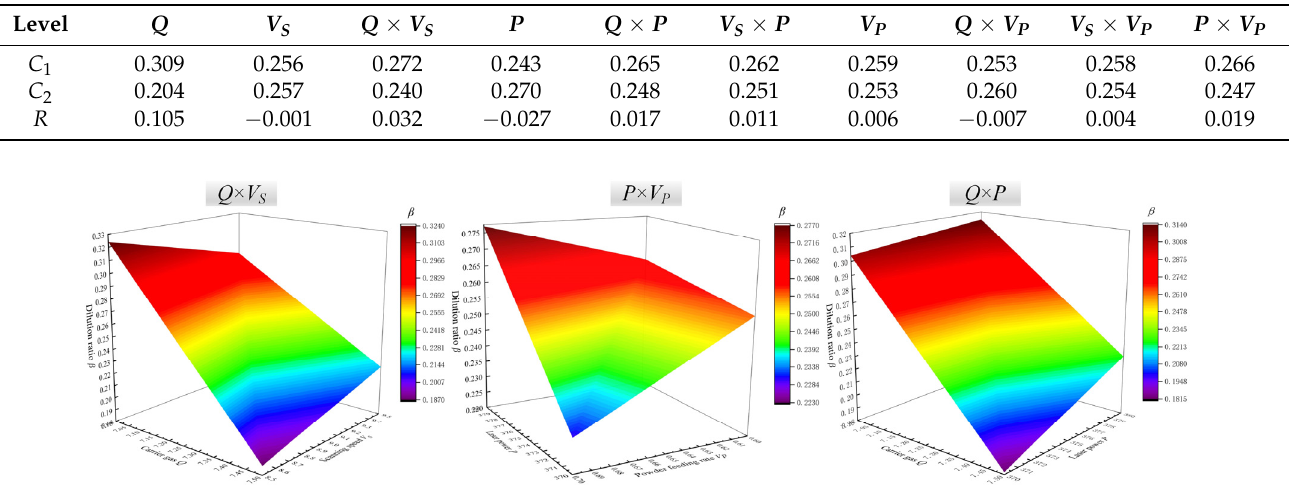
Table 5. Results of the interactive experiment.